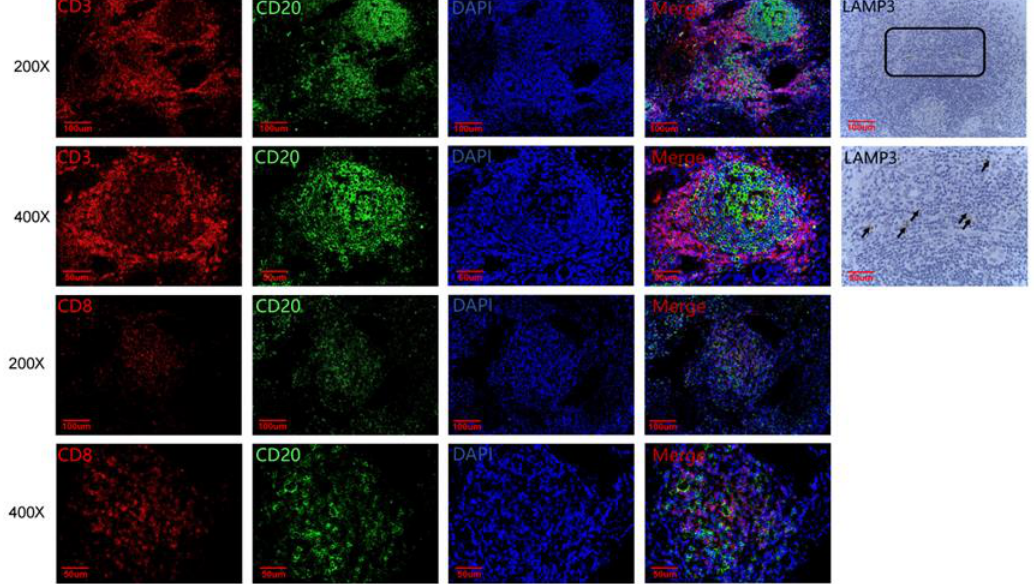
Figure 3. Xijing Hospital data, immunofluorescence/immunohistochemistry staining of CD20+ B cells, CD3+ T cells, CD8+ T cells and LAMP3+ DCs in TLSs.